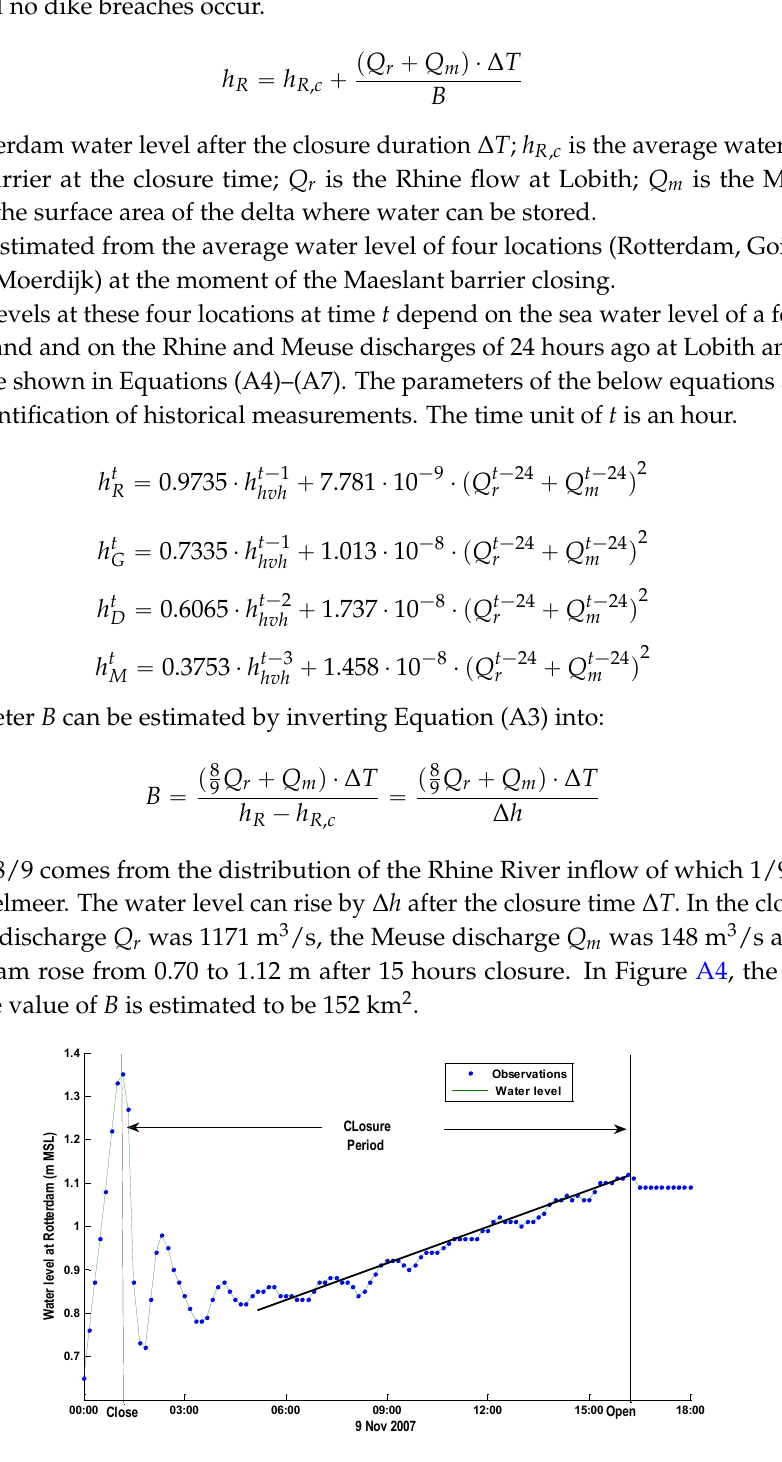
Figure A4. Rotterdam water level during the first closure event of 9 November 2007.